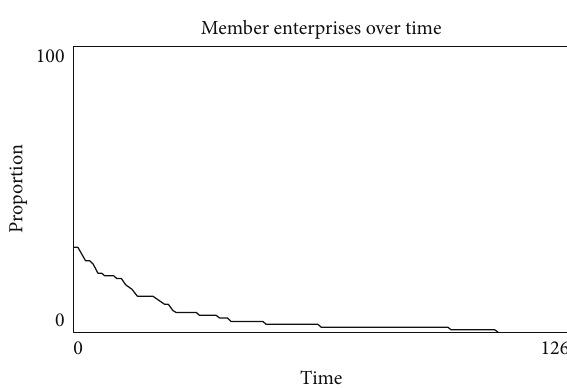
Figure 1: Simulation result for 𝑥 0 = 0.3 and 𝑦 0 = 0.4 .